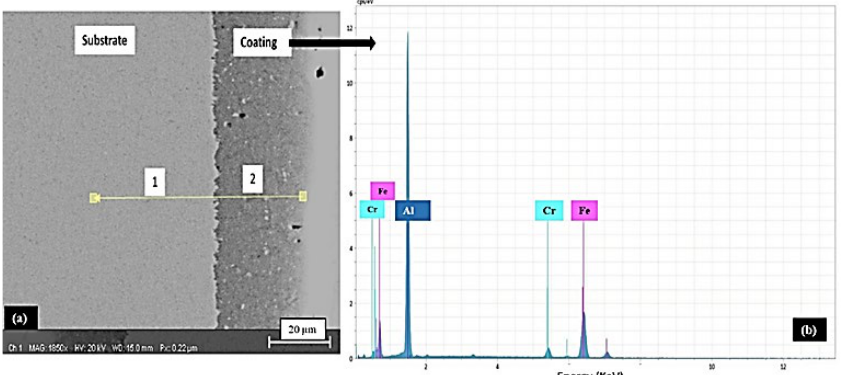
Figure 2. ( a ) The SEM micrograph of the AISI 304L substrate after the aluminizing treatment and ( b ) the EDS analysis of the same. Table 4. The EDS analysis of the AISI 304L samples after aluminizing (point area 2) in comparison to the substrate (point area 1). Please refer to Figure 2a for point area details. Area Point Elemental Composition (at. %)